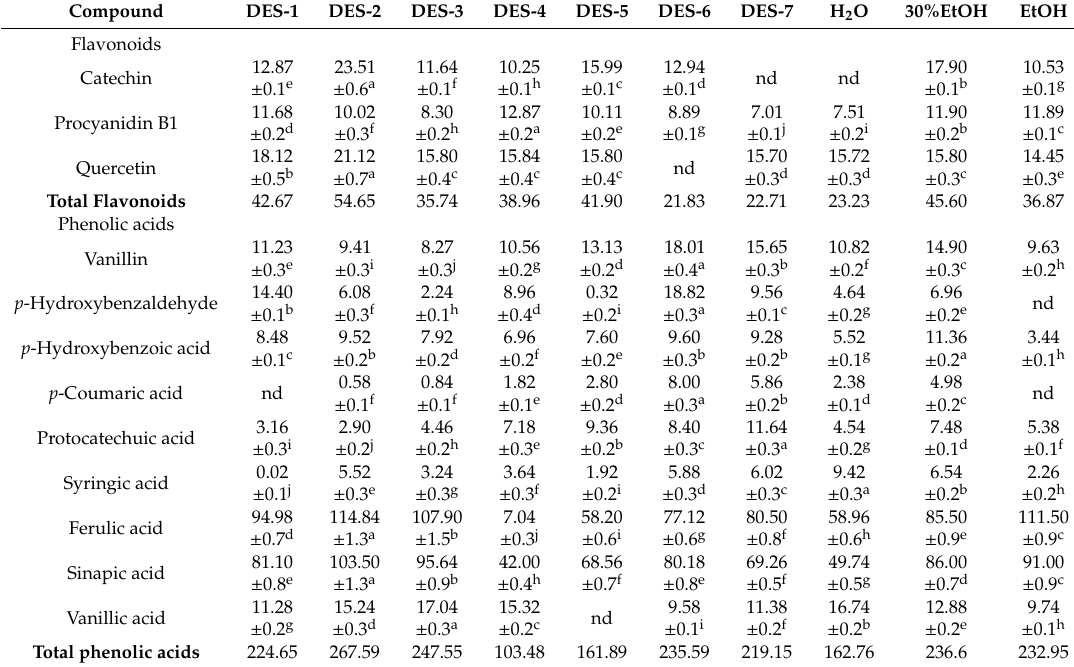
Table 3. Quantitative determination of phenolic substances and control samples obtained from wild rice using various solvents: The extraction conditions were 30% of water in DESs; extraction temperature at 50 ◦ C; extraction time of 10 min, and solid–liquid ratio of 40 mg / mL. The results are expressed as µ g / g of wild rice dry weight (n =